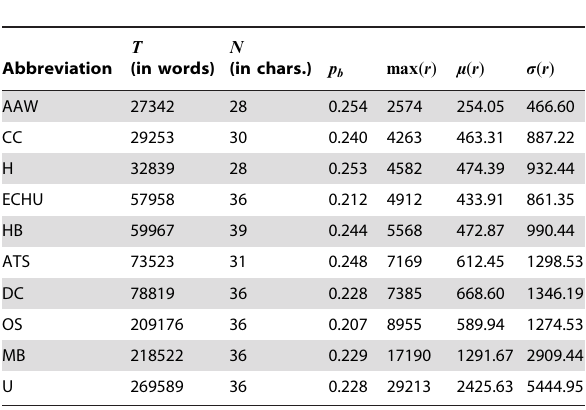
Table 2. Statistics of the English texts.